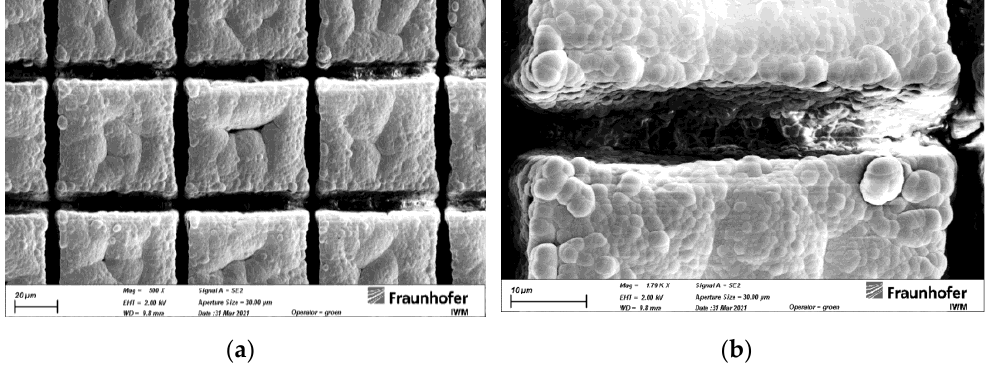
Figure 3. DLC coating on elastomer substrate with a hatch distance of 30 µm (S30). ( a ) overview with ×500 magnification and ( b ) detailed view into a trench (×1790).